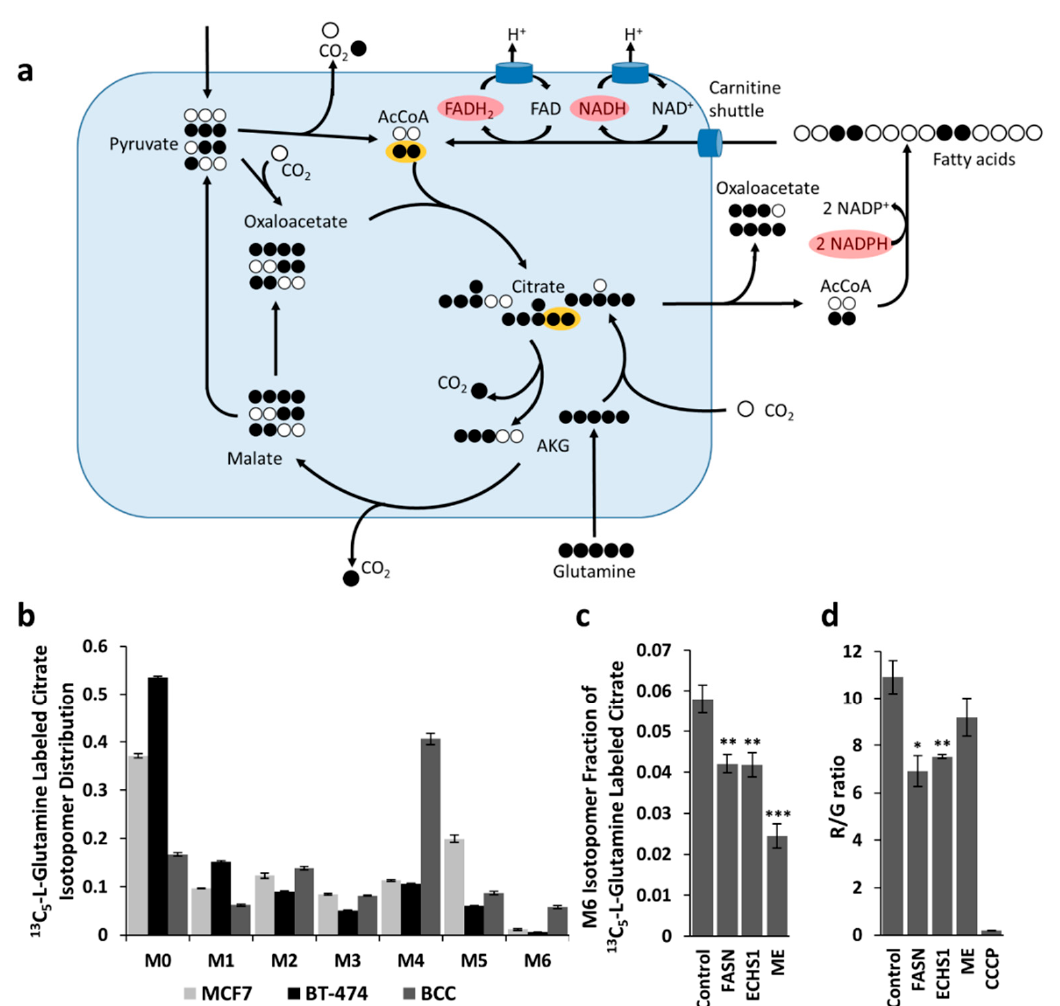
Figure 1. Experiments assessing the existence of simultaneous FAS and FAO. ( a ) Metabolic model with atomic transitions showing how degradation of fatty acids derived from glutamine or ME activity can result in the M6 citrate isotopomer, and scheme showing the shuttle of redox potential from cytosolic NADPH to the mitochondrion, formed by simultaneous FAS and FAO. Labeled carbon atoms entering the TCA cycle from FAO are indicated in yellow. ( b ) Percentages of fully labeled citrate in three different breast cancer cell lines which were fed with 13 C 5 -L-Glutamine. BCC showed 5 and 10 times more fully labeled citrate than MCF7 and BT-474 cell lines, respectively, which makes it more likely to have simultaneous FAS and FAO. Bar graphs represent mean ± SEM (n = 4). ( c ) Experimental changes in the fraction of M6 citrate resulting from the silencing of FASN, ECHS1, and ME, respectively. Bar graphs represent mean ± SEM (n = 4). ( d ) Effects of silencing FASN, ECHS1, and ME on the mitochondrial membrane potential. Bar graphs represent mean ± SEM of aggregate/monomer (R/G) ratios of JC-1 dye (n = 3). * p < 0.05, ** p < 0.01, *** p < 0.001.